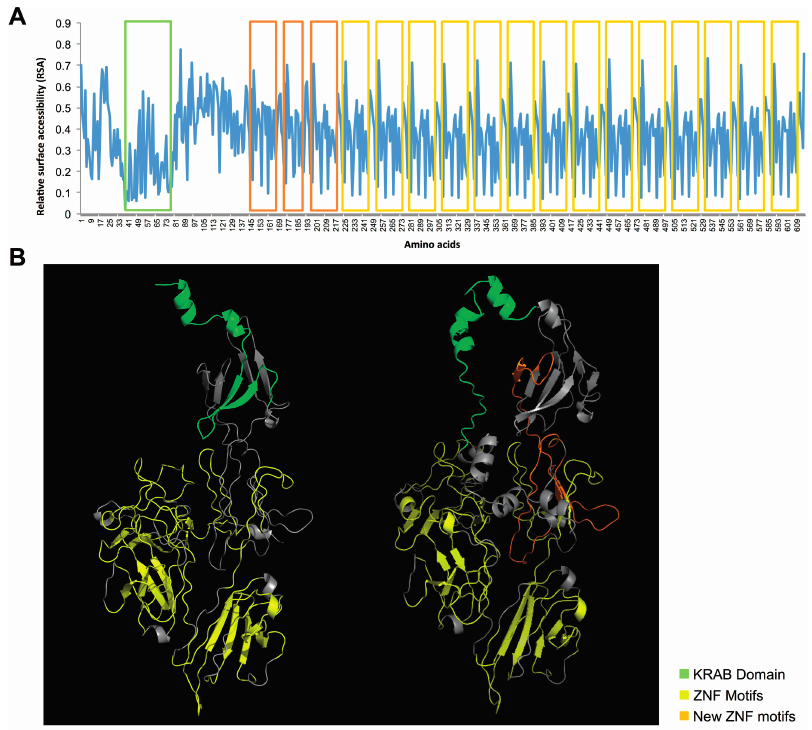
Figure 5. In silico characterization of ZNF266 predicted protein. Panel A shows relative surface accessibility (RSA) per residue; 3D structure of both annotated ( left ) and new ( right ) ZNF266 isoforms are shown in panel B . The protein backbone is shown in grey. The arrows show the direction of the beta-sheets, which is from the N - to the C -terminus. In both panels, functional domains and motifs are highlighted. In particular, the KRAB domain of the new ZNF266 isoform is shown in green, three predicted additional ZNF motifs in orange and the annotated ZNF motifs in